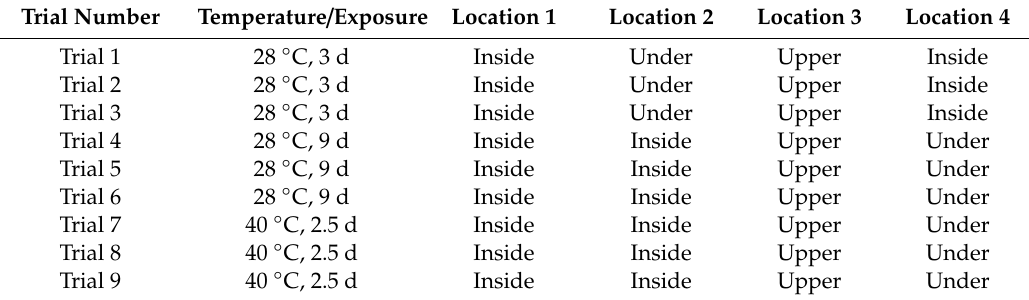
Table 1. Distribution of the vials with insects in the pallets (at the center of the pallets, at the upper part of the pallets and under the pallets), along with the conditions for each trial. Locations were slightly varied from trial to trial based on accessibility criteria.